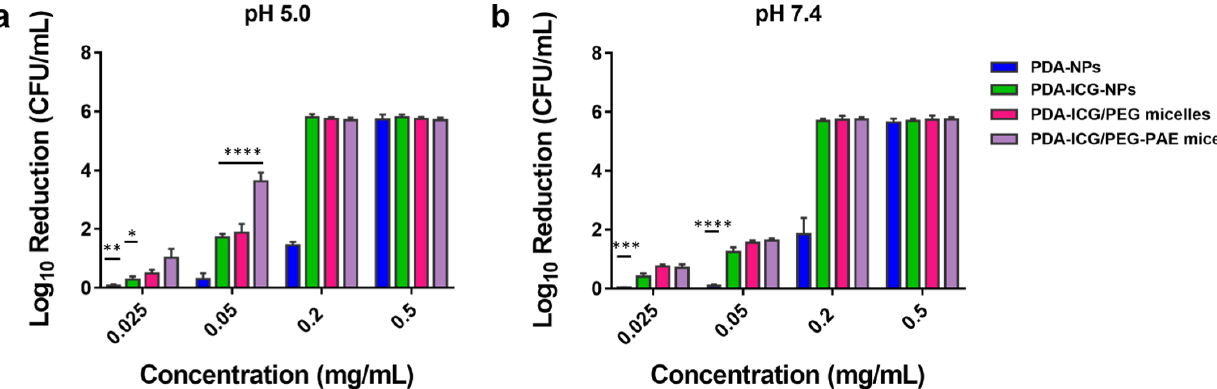
Figure 2. Photothermal killing of planktonic S. aureus Xen36 (3 × 10 6 CFU/mL) in suspensions with different concentrations of photothermal PDA-NPs and PDA-ICG-NPs after micellar encapsulation. Heat generation occurred in a suspension volume of 250 µL upon 10 min NIR irradiation (808 nm) at 1300 mW/cm 2 . ( a ) Log-reduction of staphylococci in suspension due to photothermal killing at pH 5.0 compared to NIR irradiation in absence of nanoparticles or micelles. ( b ) Log-reduction of staphylococci in suspension due to photothermal killing at pH 7.4 compared to NIR irradiation in absence of nanoparticles or micelles. Data represent means with standard deviations over 3 experiments with separately prepared batches of nanoparticles and bacterial cultures. * indicate statistically significant differences between the data indicated by the spanning bars (two-way ANOVA; * p < 0.05, ** p < 0.01, *** p < 0.001, **** p < 0.0001).